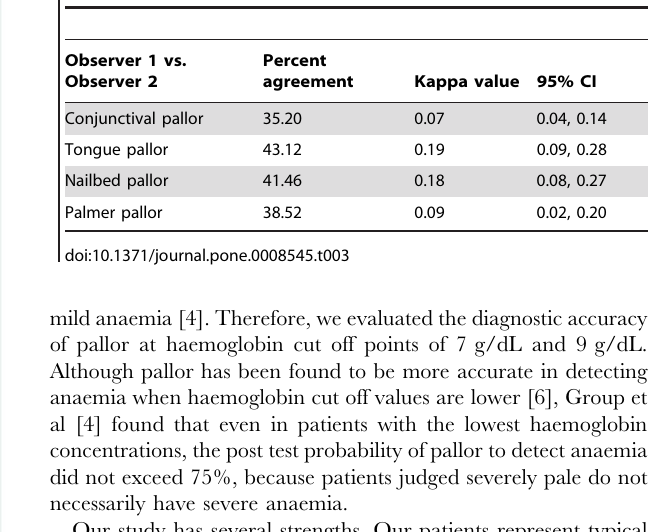
Table 3. Interobserver variability in assessment of anaemia (n=128).